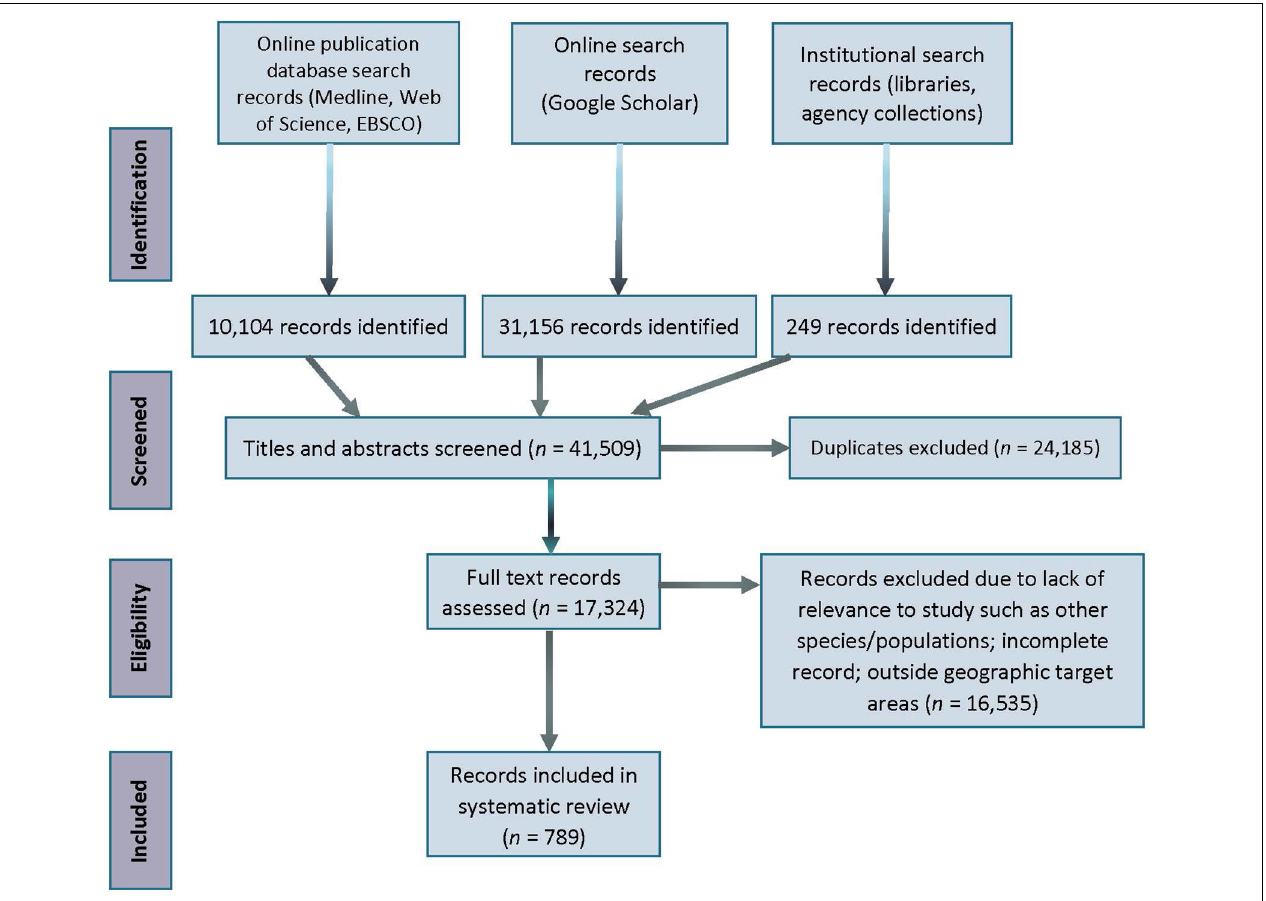
FIGURE 3 | PRISMA literature record search flow diagram. At each stage of the review process, the number of records that were located, discarded, and retained are indicated at each stage (1975–2020). Relevant publications from January to May 2021 are included in the count.